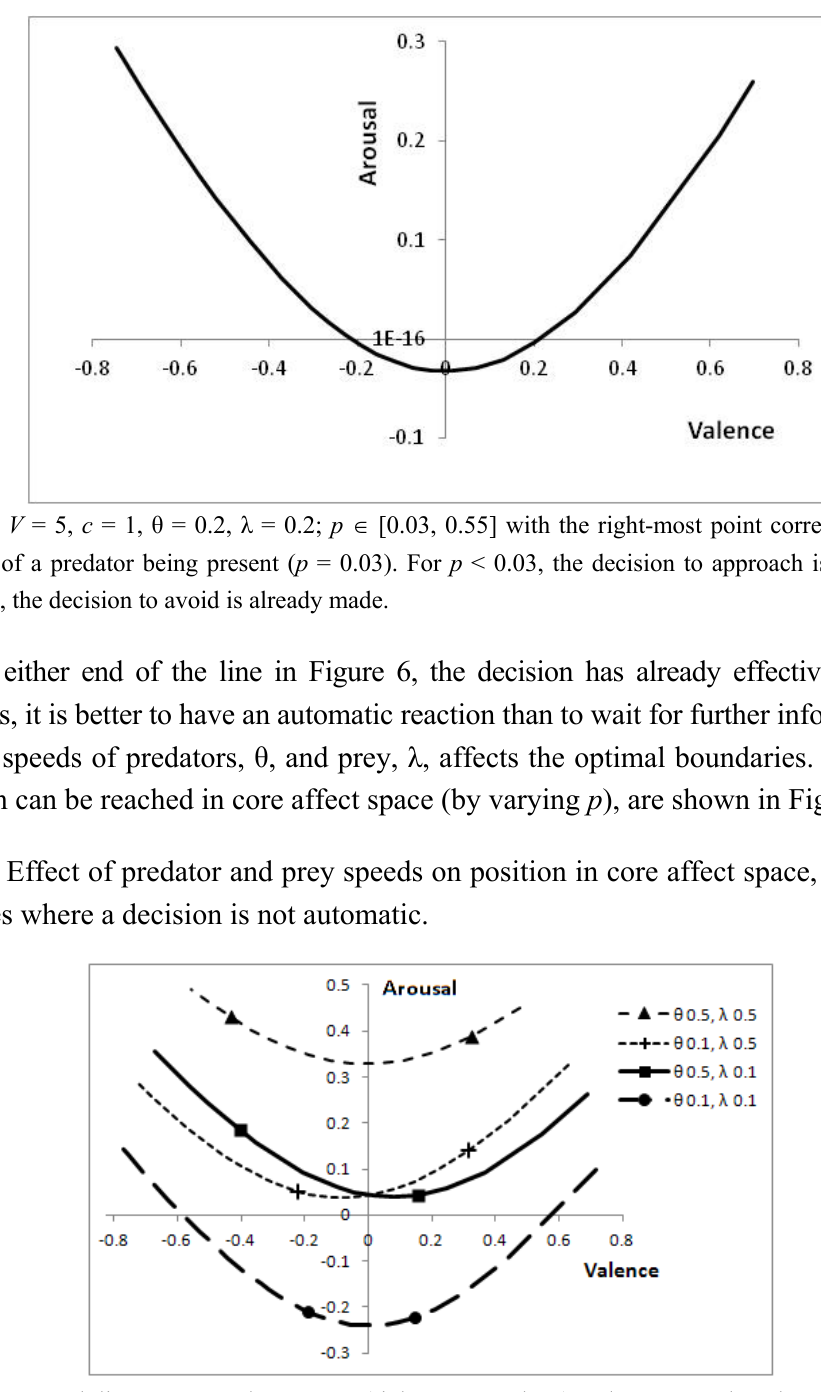
Figure 6. Positions reached in core affect space as p is